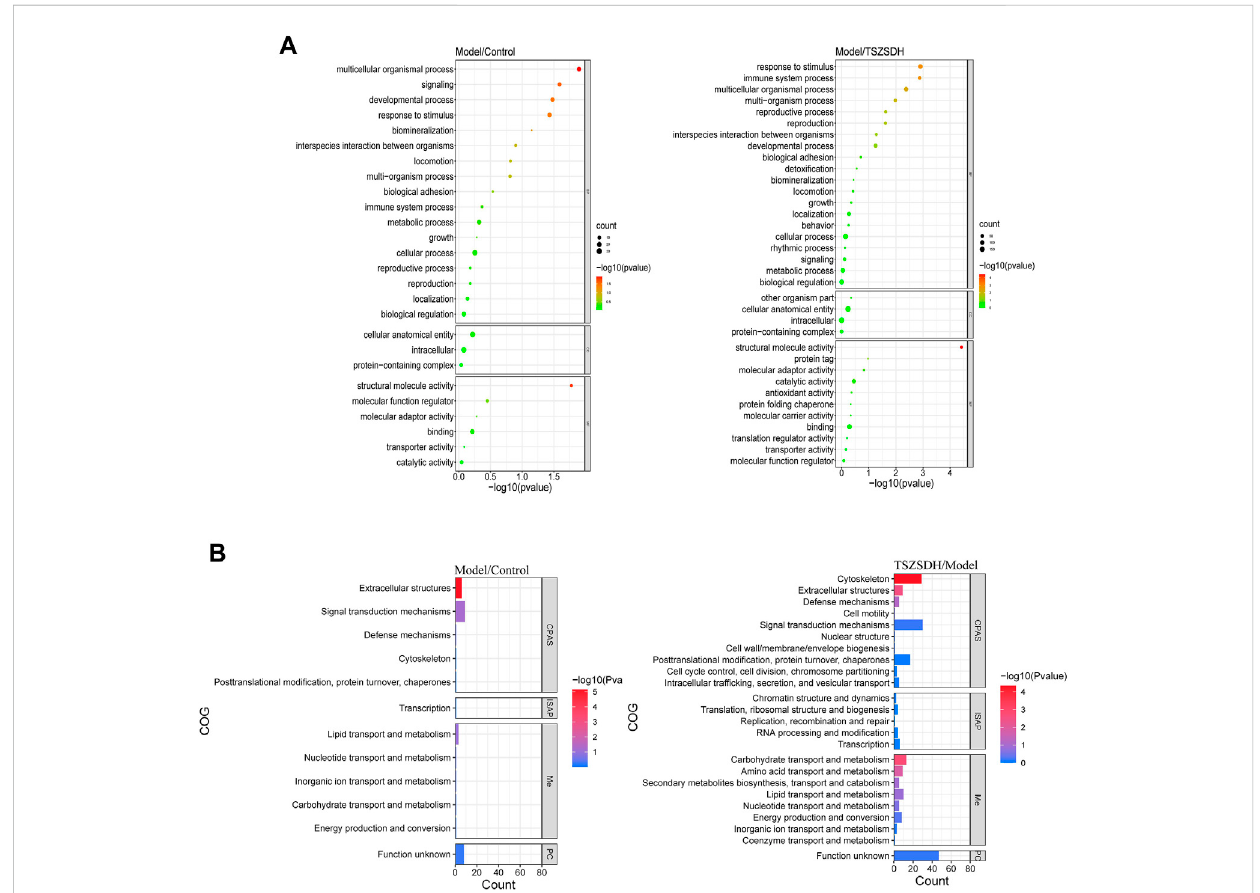
FIGURE 4 (A) GO terms comparison between the model and control groups, and between the TSZSDH and model groups. The size of the dots represents the number of gene proportions, and the color represents the p -value. The greener the color, the smaller the -log10( p -value), and the redder the color, the greater the -log10( p -value). (B) COG annotations comparison between the model and control groups and the TSZSDH and model groups. The length of the bar graph represents the number of gene proportions, and the color represents the value. The bluer the color, the smaller the -log10( p -value), and the redder the color, the larger the -log10( p